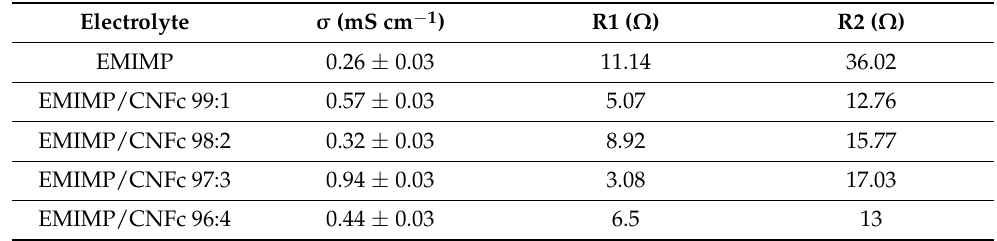
Table 1. Ionic conductivity and resistances of the different EMIMP/CNFc gel electrolytes and pristine EMIMP ionic